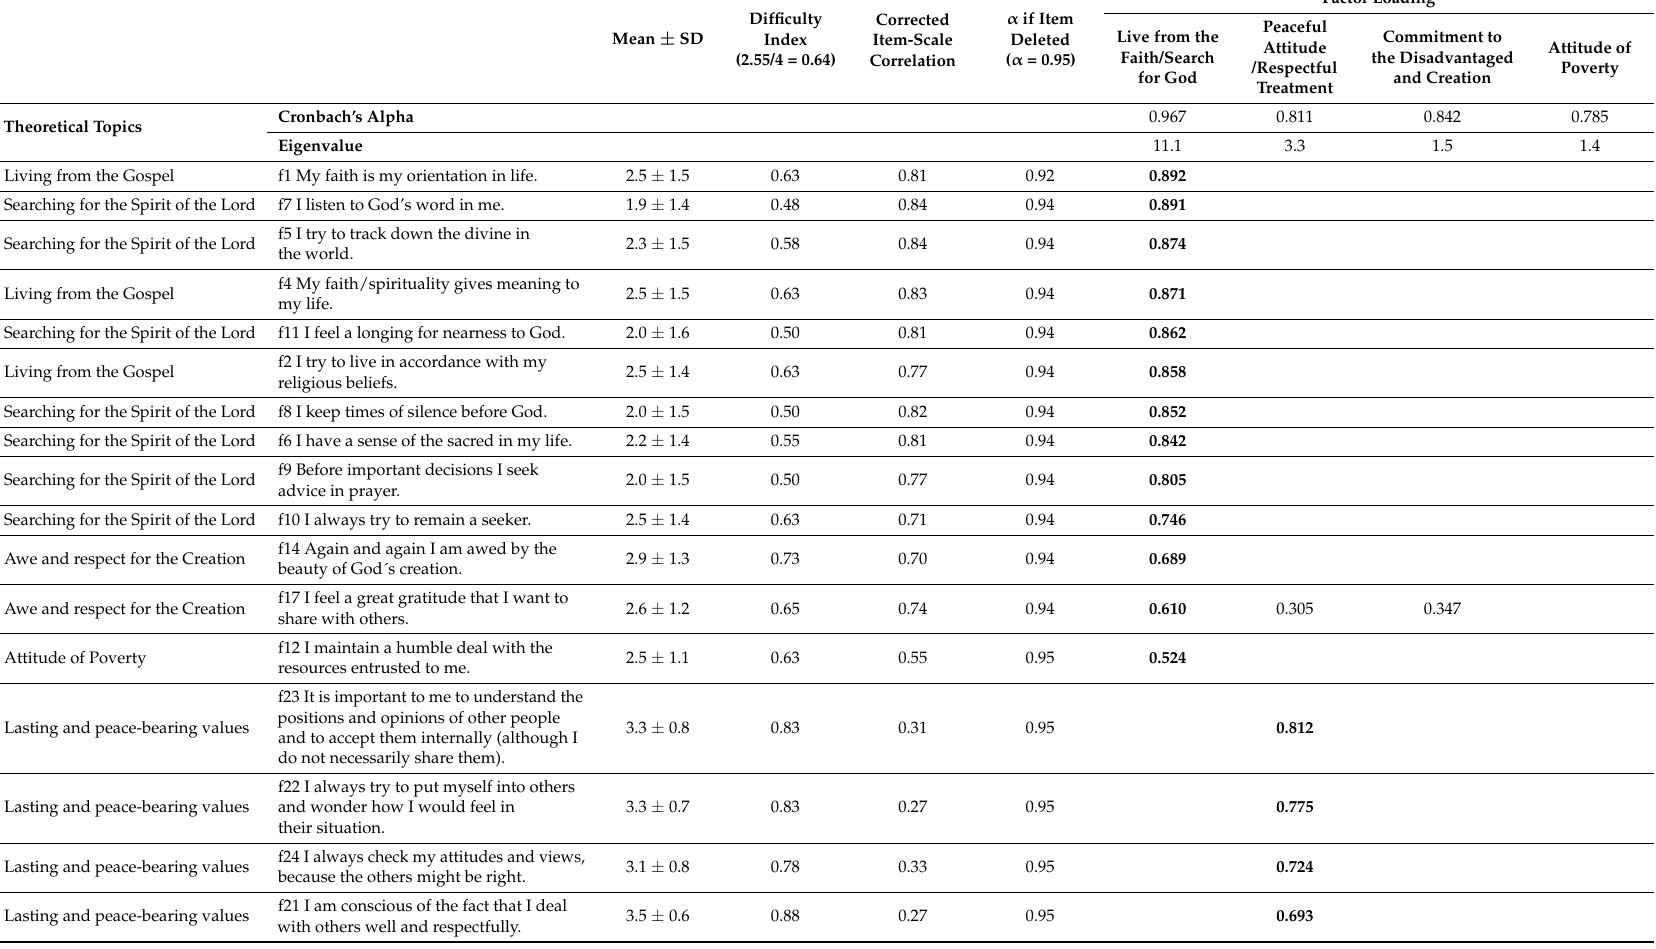
Table 2. Reliability and factorial